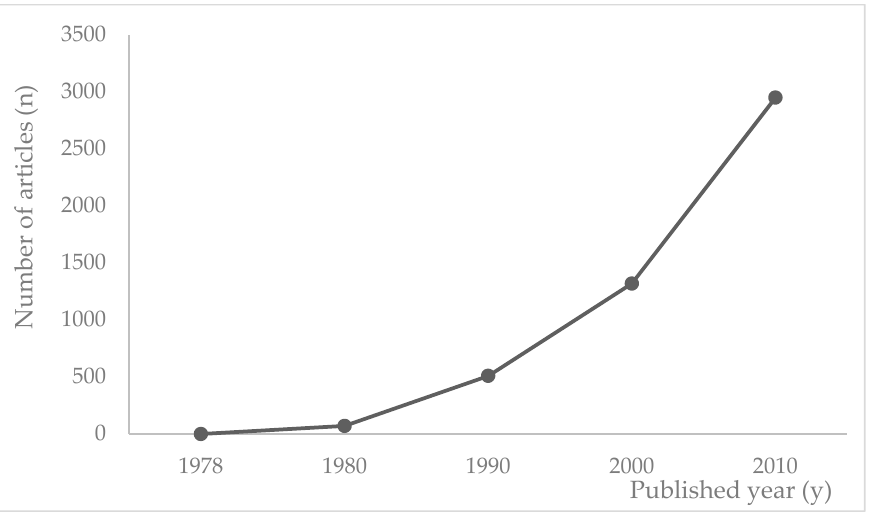
Figure 1. Number of published articles on infection research during 40 years in the nursing field.